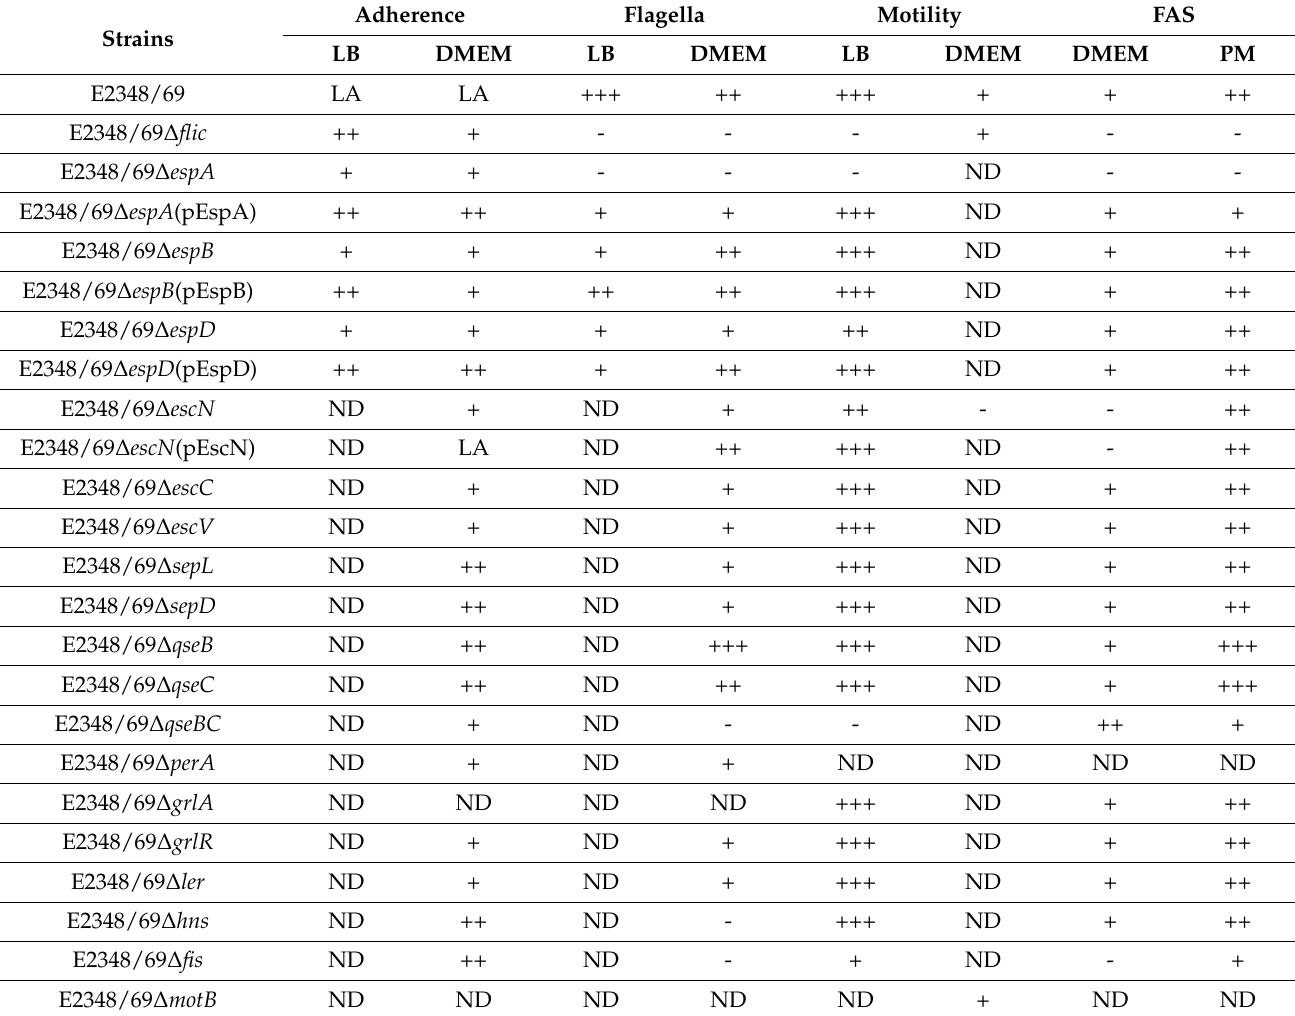
Table 1. Fluorescent actin-staining (FAS) assay, adherence, flagella presence, and motility of E2348/69 and derived